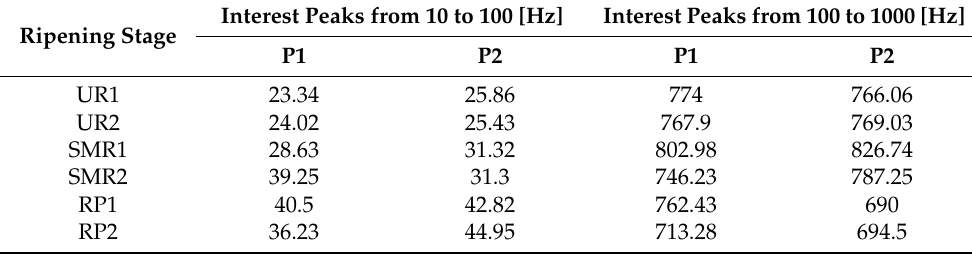
Table 3. Interest resonance peaks in the ranges of 10–100 Hz and 100–1000